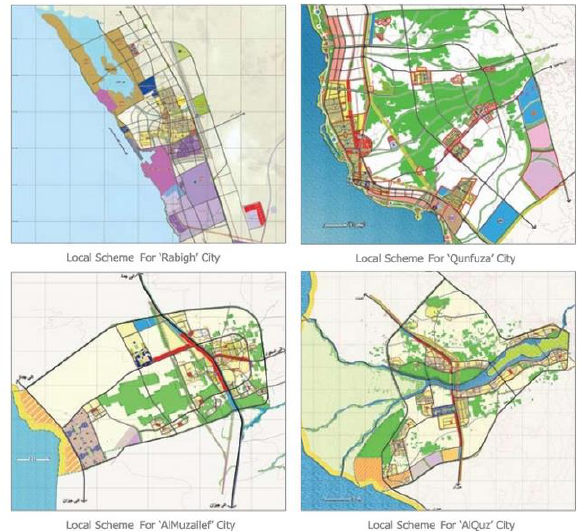
Fig. 1 : Example of GIS datasets in Province department within Jeddah Municipality (Municipility, 2015).